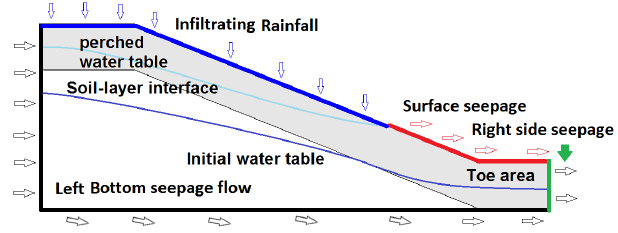
Figure 3. Flow component and water balance of study